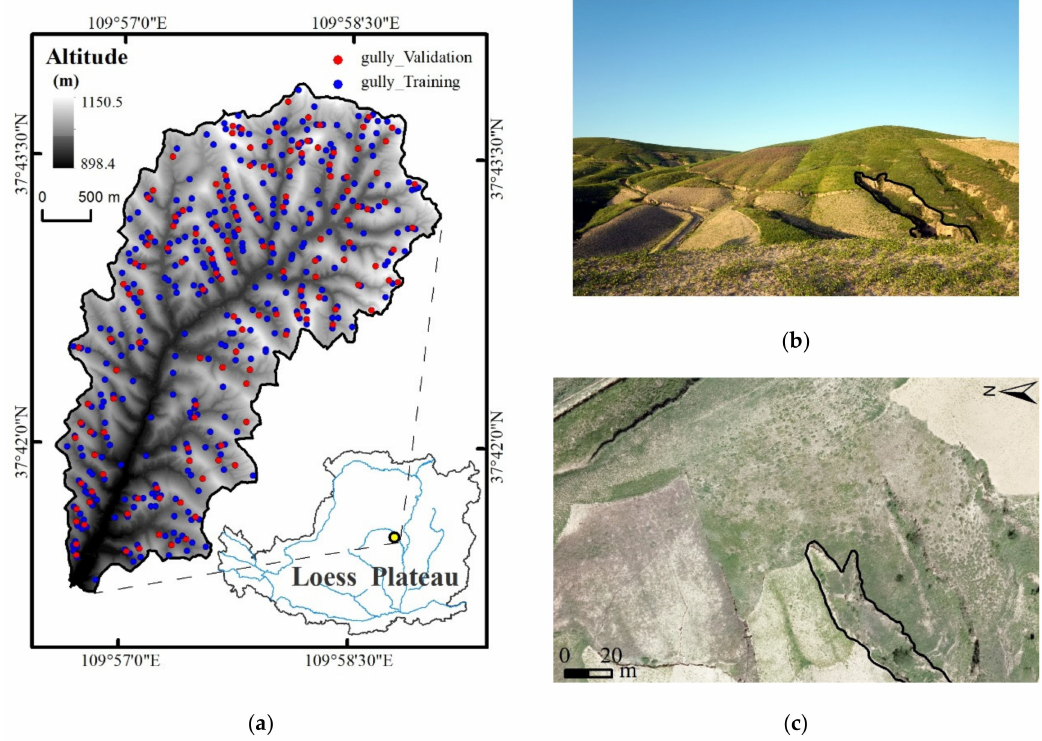
Figure 1. Study area. ( a ) Altitude surface of the study area based on UAV-sourced DSM and locations of watershed and gullies sampled. ( b ) Photo of a typical gully. ( c ) Typical gully in UAV-sourced